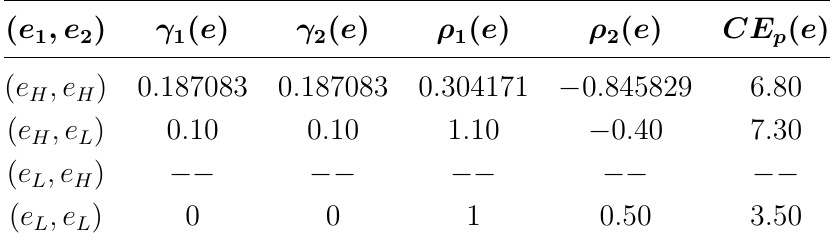
Table 4. Optimal team contracts of Example